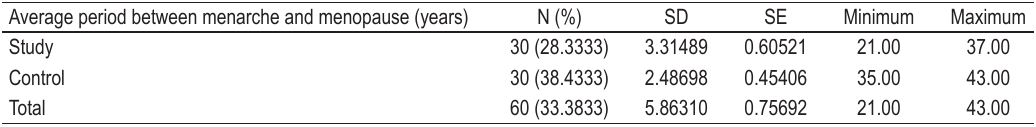
TABLE 4. Comparison of average period between menarche and menopause by groups Average period between menarche and menopause (years)